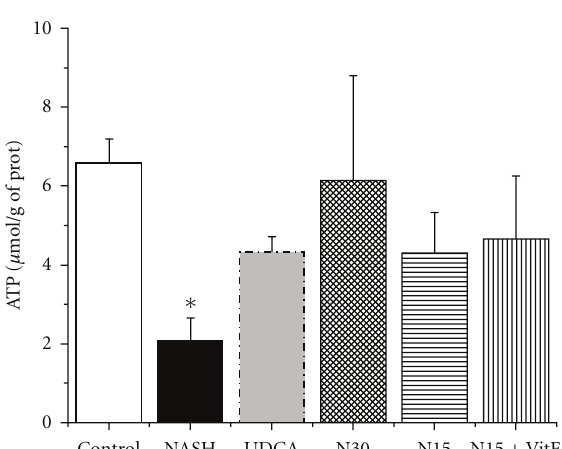
Figure 5: E ff ect of treatments on mitochondrial ATP.